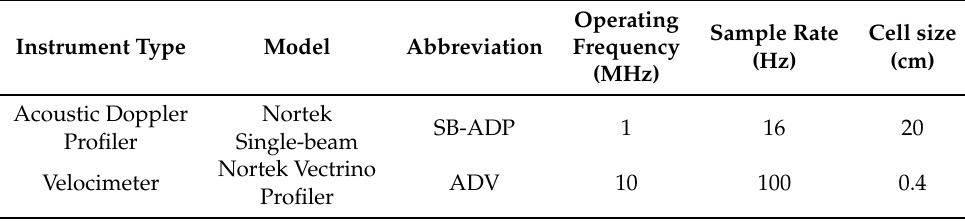
Table 2. Instruments characteristics during